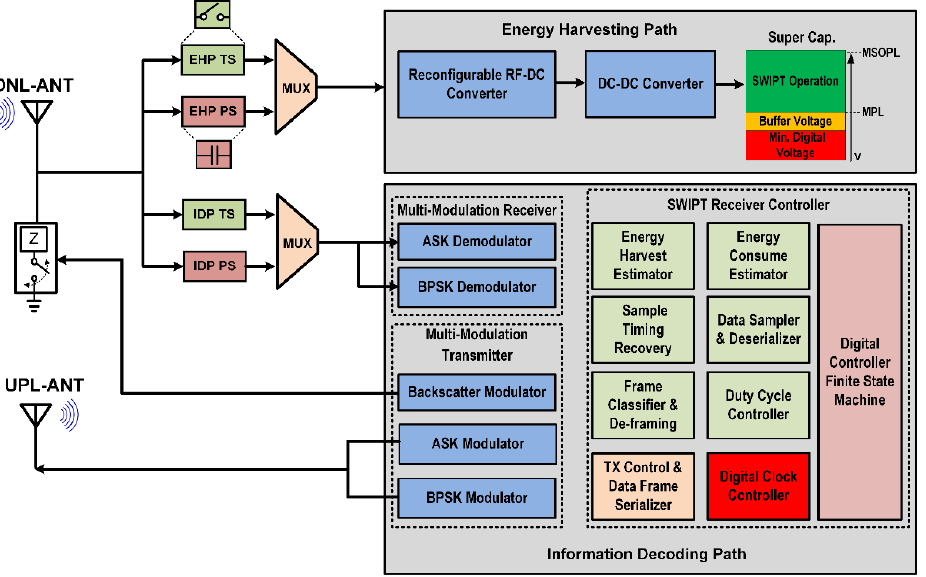
Figure 2. Architecture of the proposed SWIPT receiver with the ACCP.